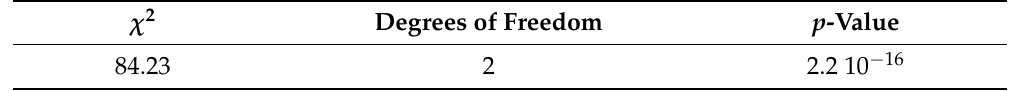
Table A1. Results of the Kruskal–Wallis test on the CO 2 showing that significant differences exist.